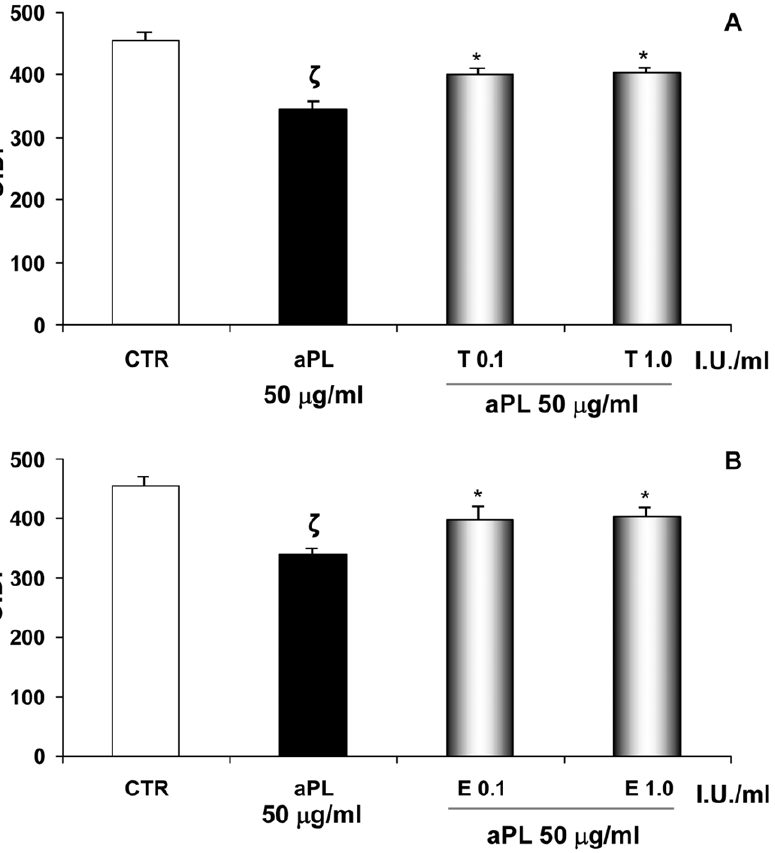
Figure 4. VEGF expression. VEGF secretion in HEEC culture medium was determined by a human VEGF colorimetric ELISA kit. Supernatant samples were collected after 24 hrs of aPL (50 m g/ml) and tinzaparin (A) or enoxaparin (B) (0.1–1.0 IU/ml) treatment for VEGF measurement. Results are mean 6 SE of four independent experiments and are expressed O.D. (Optical Density). CTR: untreated cells; T: tinzaparin; E: enoxaparin; O.D.: Optical Density; I.U.: International Units; f : P , 0.05 compared with CTR; *: P , 0.01 versus aPL treatment.